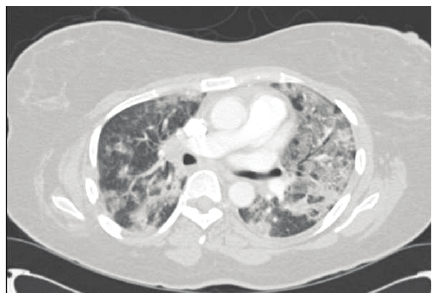
Figure 2: Showing computed tomography. There is moderate right hilar and mediastinal lymphadenopathy measuring up to 1.6cm in short axis in the right hilum. The heart is moderately enlarged in size. There is a mosaic pattern of fairly dense opacity seen diffusely